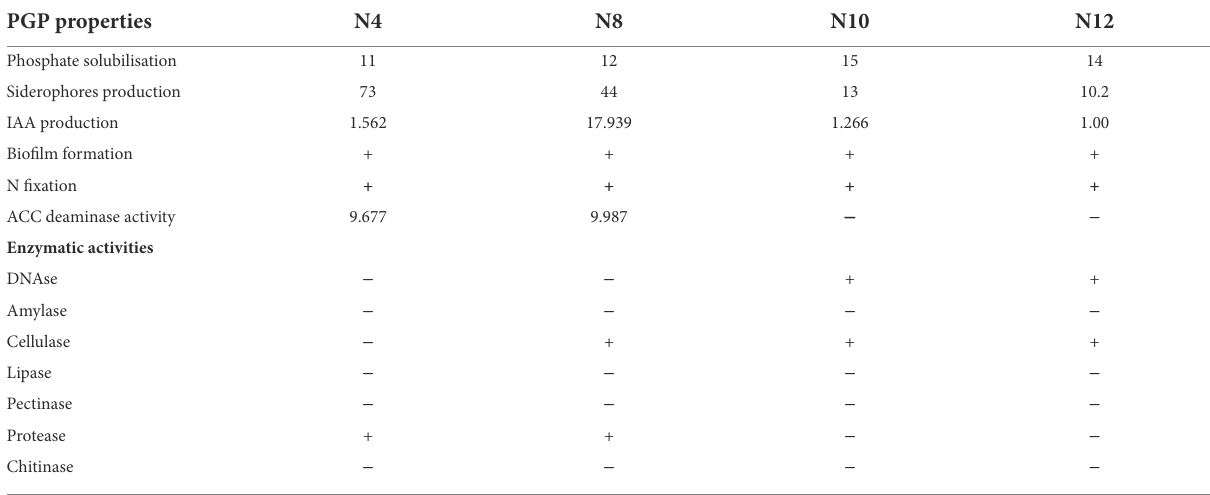
TABLE 3 PGP properties and enzymatic activities showed by selected